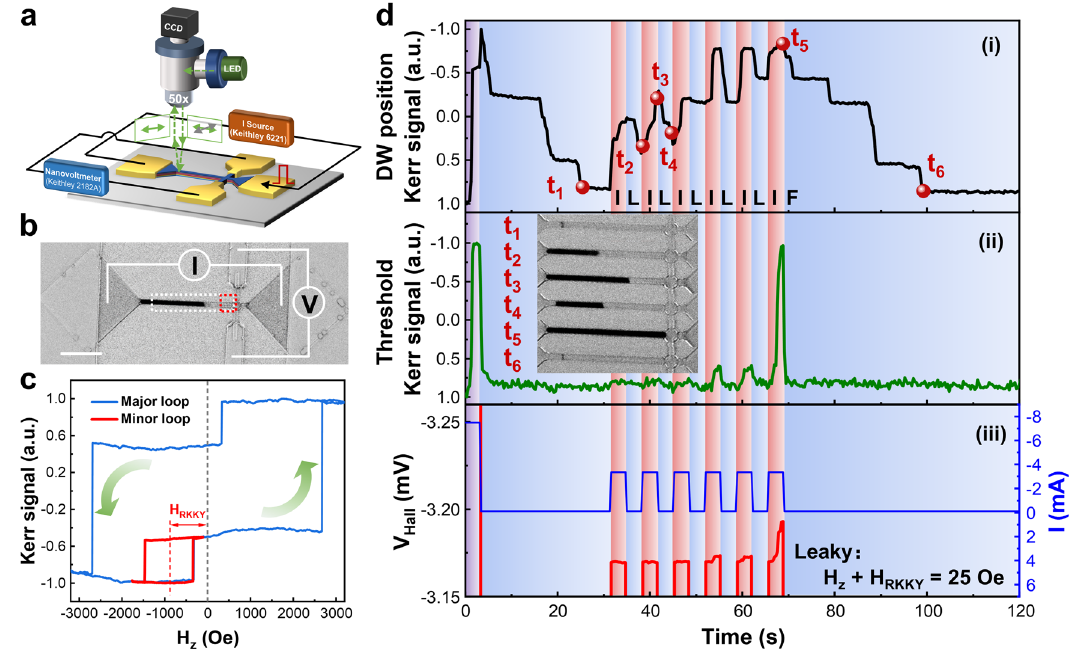
Fig.2|PrototypespintronicneurondevicewithLIFcharacteristics.a Schematic of p-MOKE setup for in-situ magneto-electrical transport probing. b Kerr image withtheyellowdashed boxindicating DWstripe and Kerrsignalin d (i),reddashed boxrefers to the threshold regionand corresponding Kerr signalin d (ii). The scale bar is 20 μ m. c Major K-H Loop of the device. H RKKY refers to effective fi eld from RKKY interaction and is equaled to 885Oe. d Dynamic DW motion emulated LIF